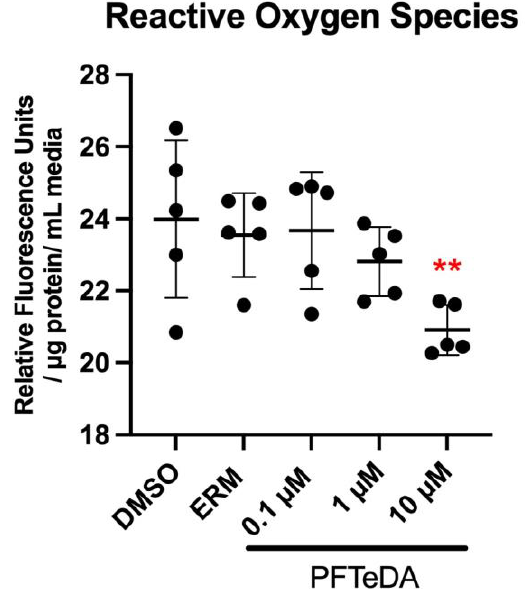
Figure 3. Normalized reactive oxygen species level in larval zebrafish treated with ERM, 0.1% DMSO, 0.1 μM, 1 μM, and 10 μM PFTeDA. Each point is a biological replicate and the horizontal line indicates the mean value of the group (mean ± S.D.) (one-way ANOVA followed by a Dunnett’s multiple comparisons test, n = 5/group). ** indicate that the values are significantly different from those of the control group at p < 0.01.